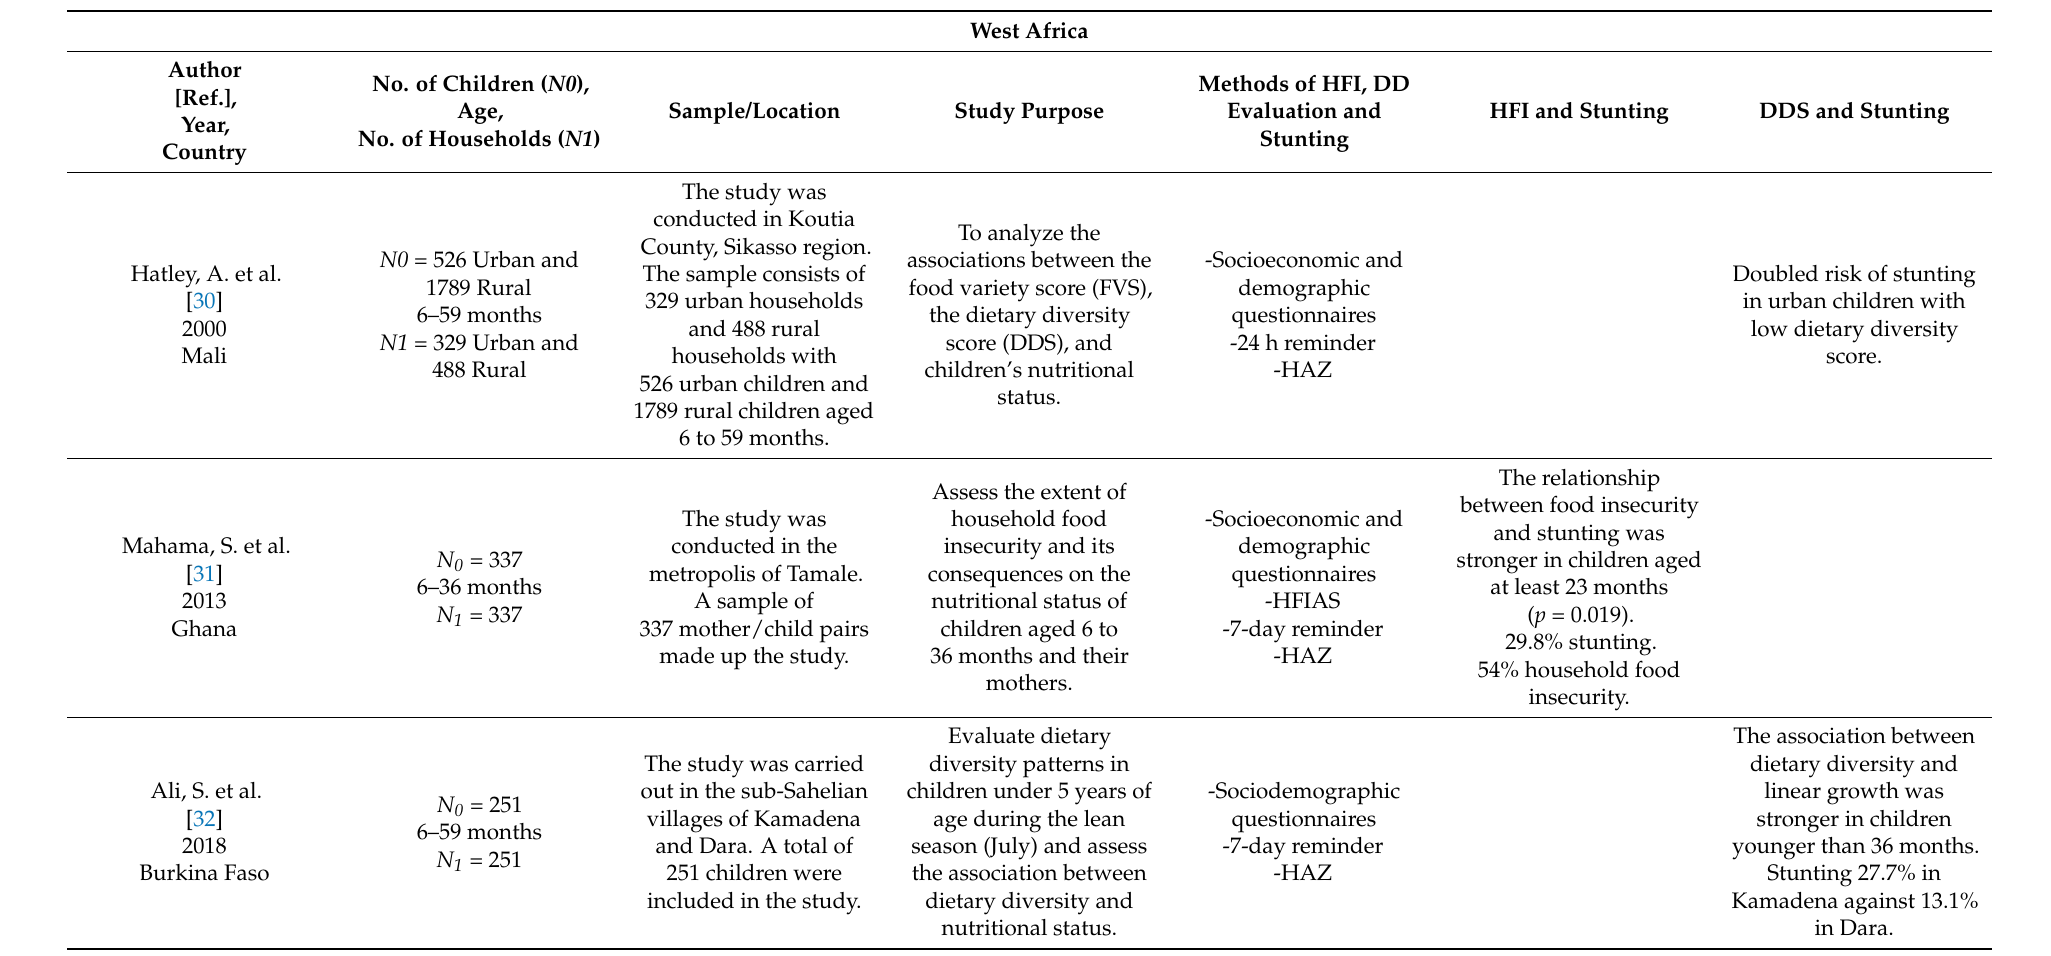
Table 1. Summary of selected